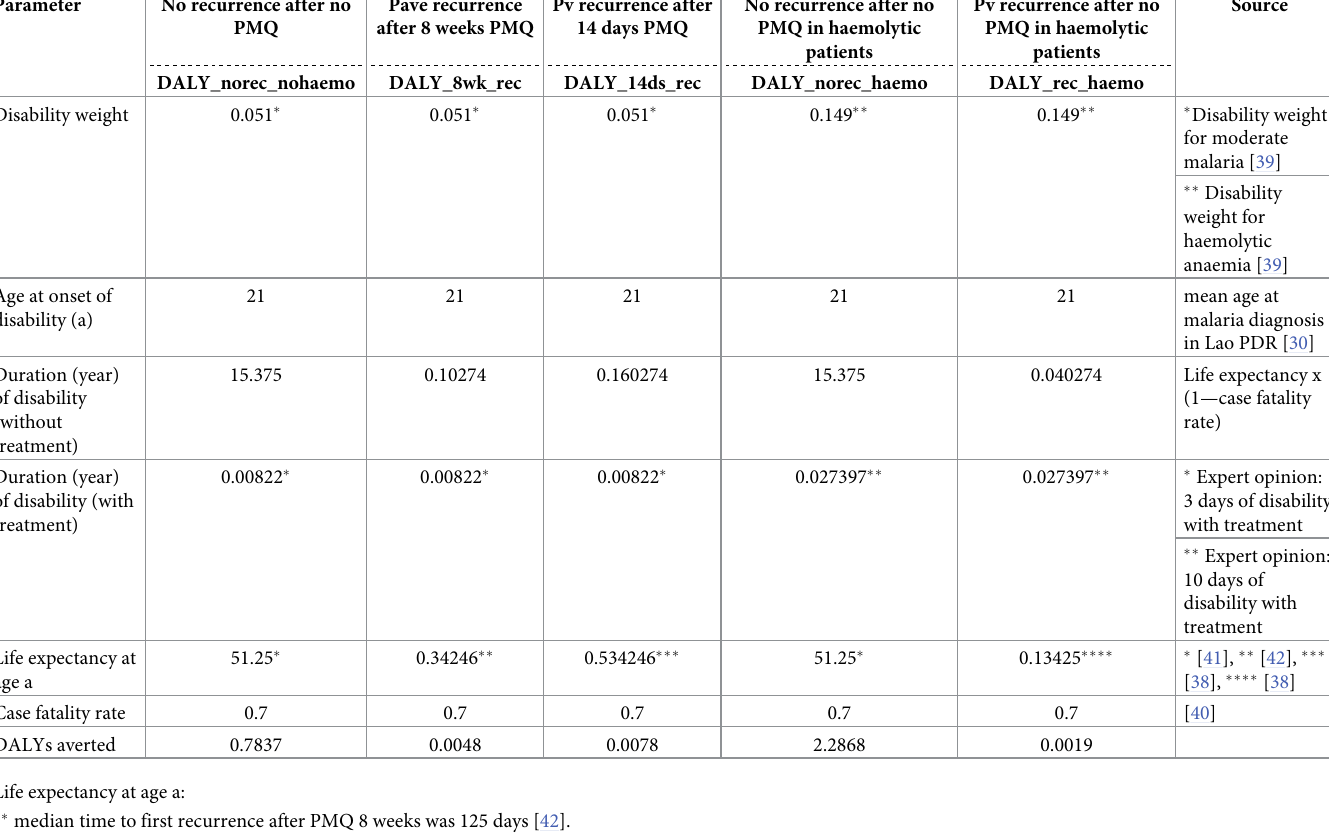
Table 2. Parameters for calculation of